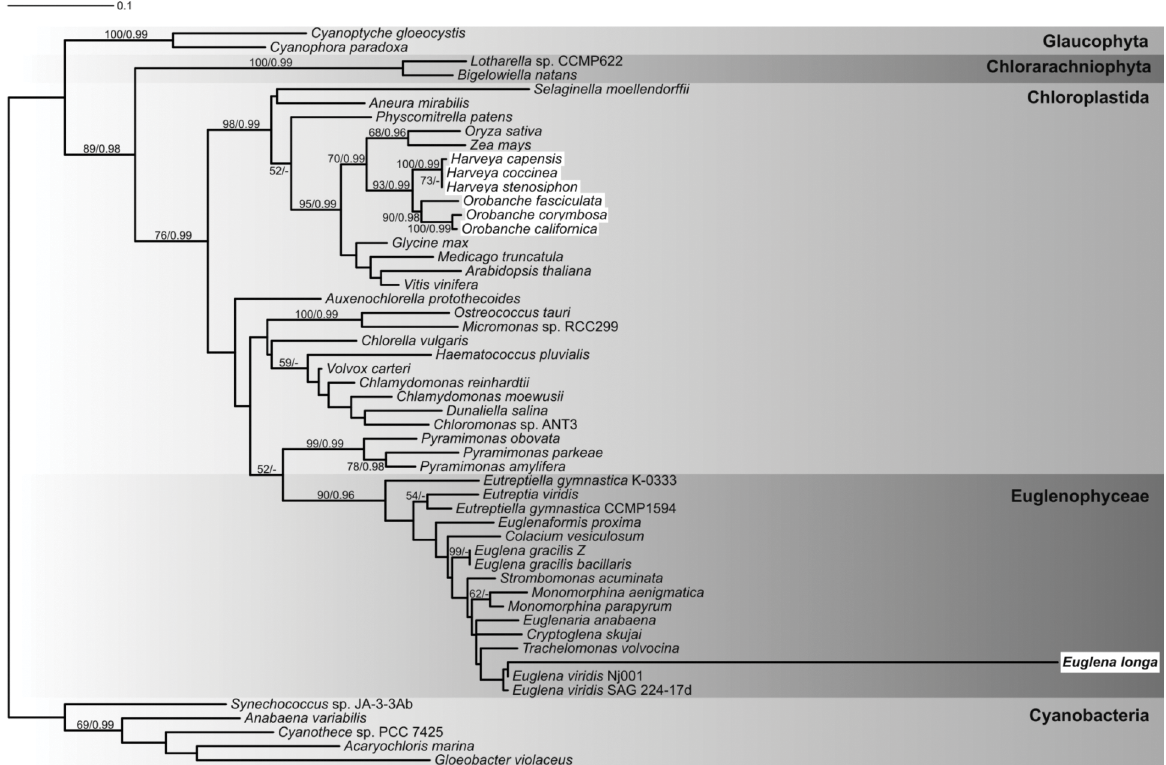
Fig 1. Phylogenetic tree of RBCL protein sequences. The maximum-likelihood tree was inferred with RAxML using the LG+ Γ substitution model. The bootstrap support values and posterior probabilities (from PhyloBayes) are indicated at branches when higher than 50% and 0.95, respectively. Highlighted in white boxes are non-photosynthetic species. E . longa is in bold.